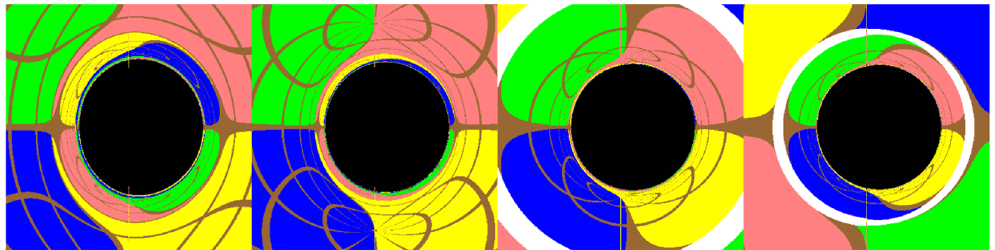
Figure 3 . The change of black hole shadow with the coupling constant α for the metric (2.22). Here we set the black hole M = 1 and rotation parameter a = 0 . 5, and the observer locates in the position with r obs = 50 M and θ obs = π/ 2. The figures from left to right correspond to α = 0 . 2, 0, and 0 . 2, respectively. −